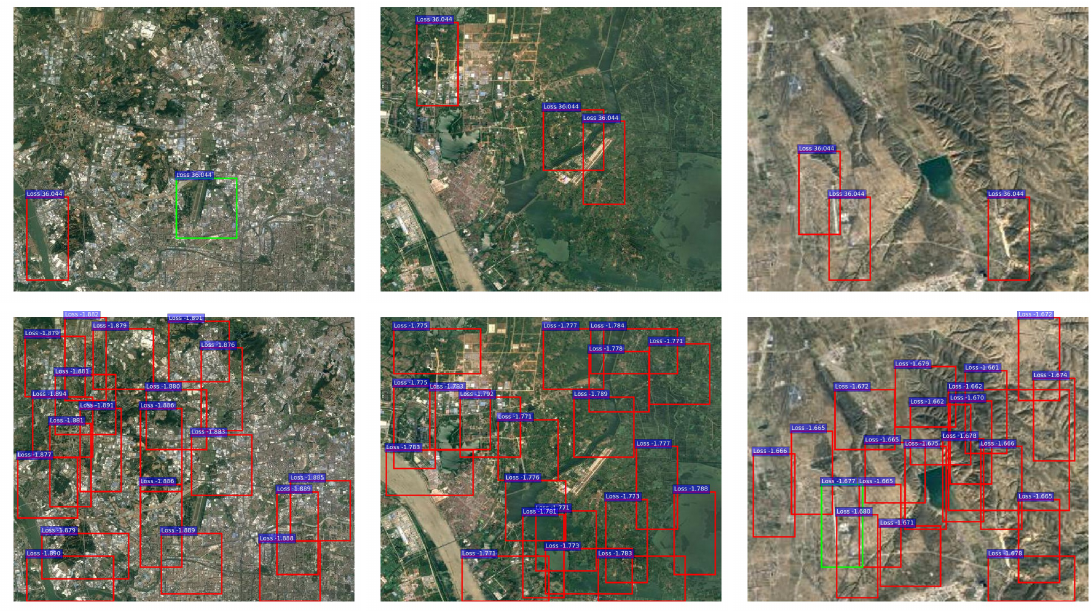
Figure 5. Hard and easy examples. The first row lists hard examples. The second row denotes easy examples. The positive and negative examples are indicated by green and red rectangles, respectively.